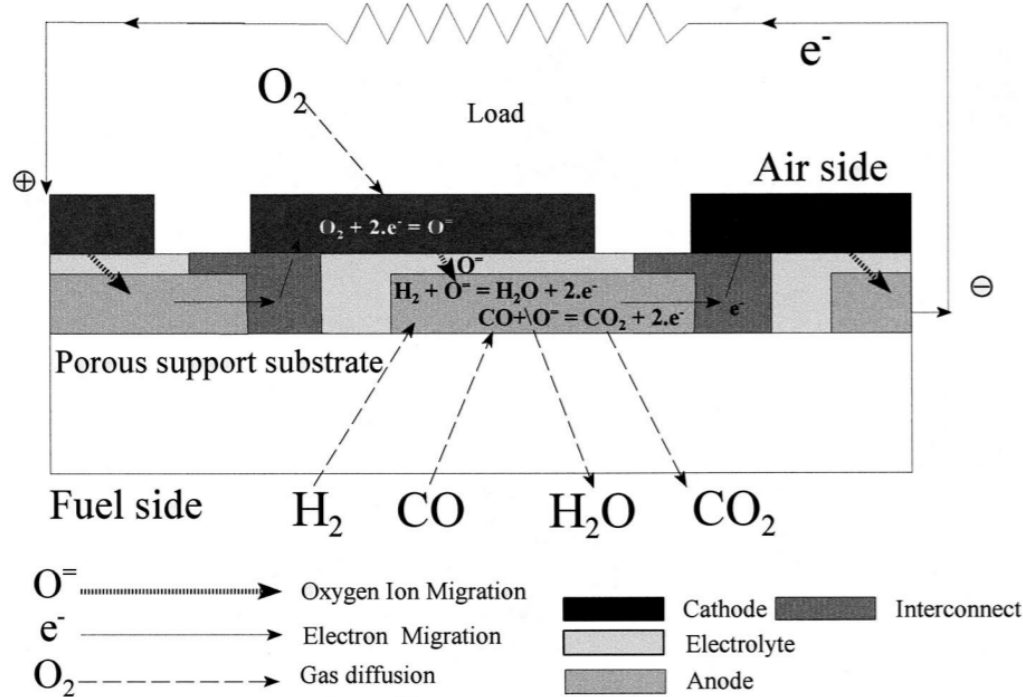
Figure 7. Schematic of BSC with micro-channels (figure reprinted from Gardner et al. [47] Copyright (2000), with permission from Elsevier).